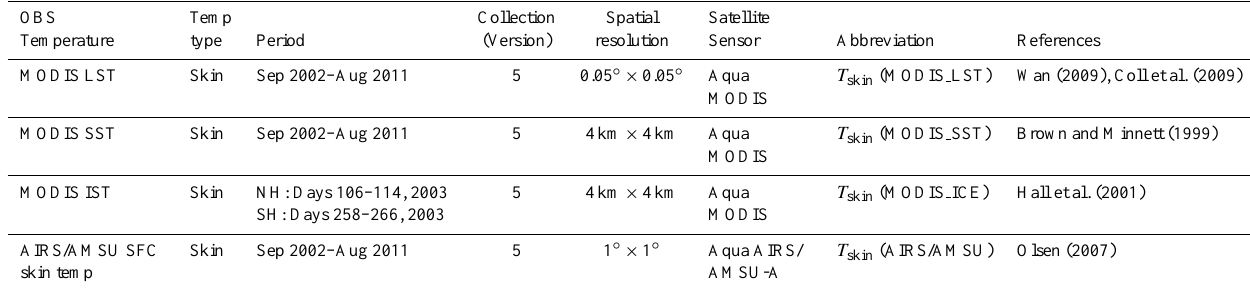
Table 1. The satellite data information during the period from September 2002 to August 2011 used in this study. Here the abbreviations are as follows; LST (land surface-skin temperature), temp (temperature), SST (sea surface-skin temperature), IST (ice surface skin temperature), NH (Northern Hemisphere), and SH (Southern